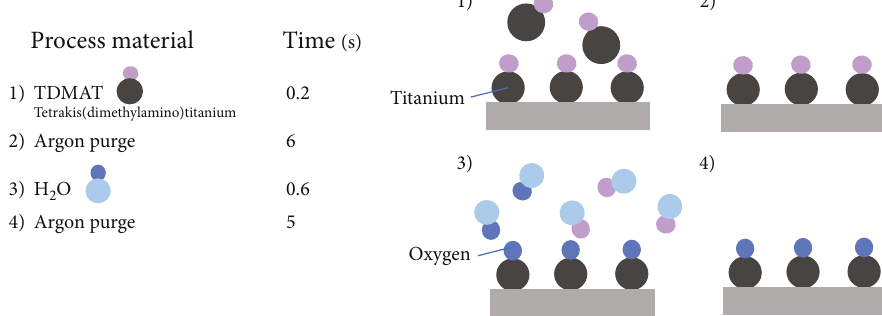
O enters the chamber 2